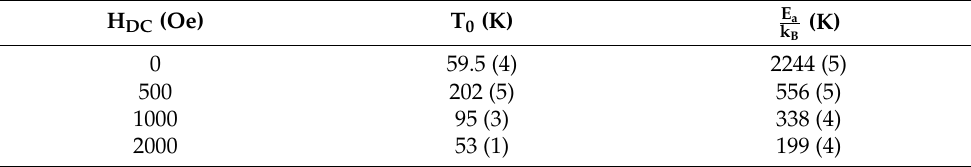
Figure 4. Vogel–Fulcher (V–F) plots under DC fields of ( a ) 0 Oe; ( b ) 0.5 kOe ( c ) 1 kOe and ( d ) 2 kOe T M values were determined from χ ”(T) curves and for different frequencies. The full lines represent the result of the fits of the experimental data obtained from the AC magnetic χ curves recorded under different DC fields. Table 1. Values of the T 0 , and E a parameters obtained after fitting the dependence of the T M for χ ”(T) k B curves recorded under several DC fields using the V–F